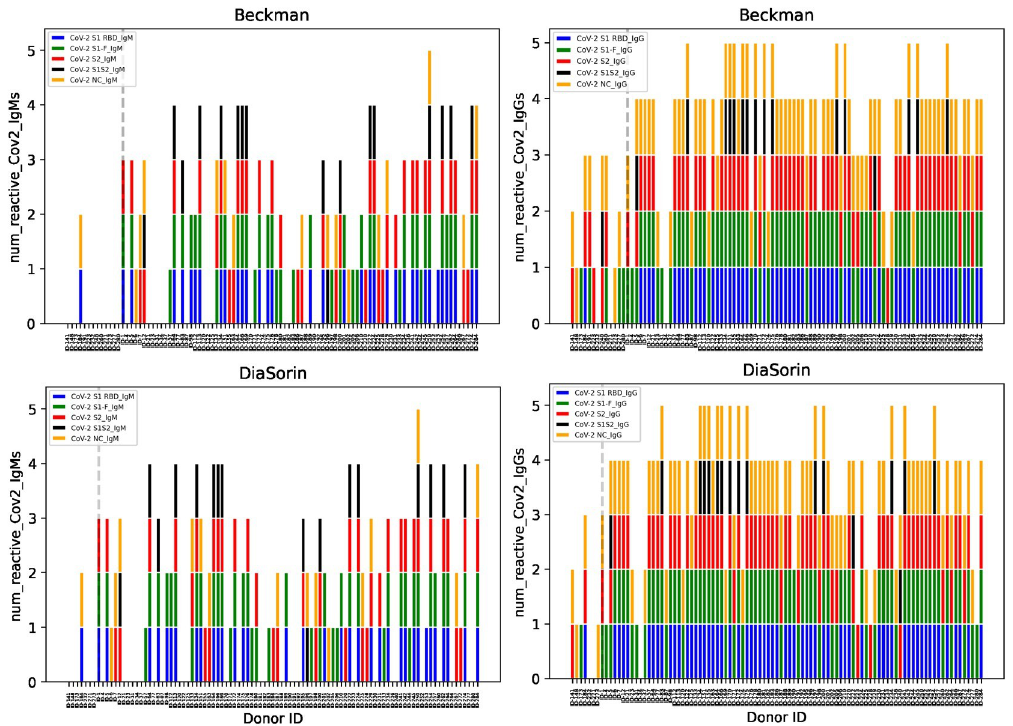
Fig 1. Comparison of Genalyte target-specific results with Beckman and DiaSorin results. The number of Genalyte assay reactive SARS-CoV-2 IgM (left) or IgG (right) specific targets for samples that were also tested on the Beckman (top row) and DiaSorin (bottom row) assays are shown for each sample tested. In each plot, false negative samples on the Beckman and DiaSorin assays are shown to the left of the dotted grey line.